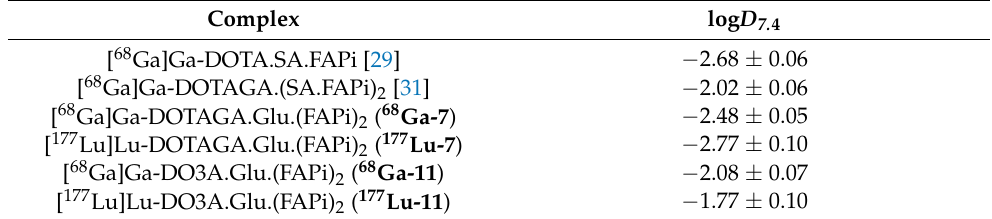
Table 2. log D 7.4 values of different labeled FAPi-based radiopharmaceuticals. The values for [ 68